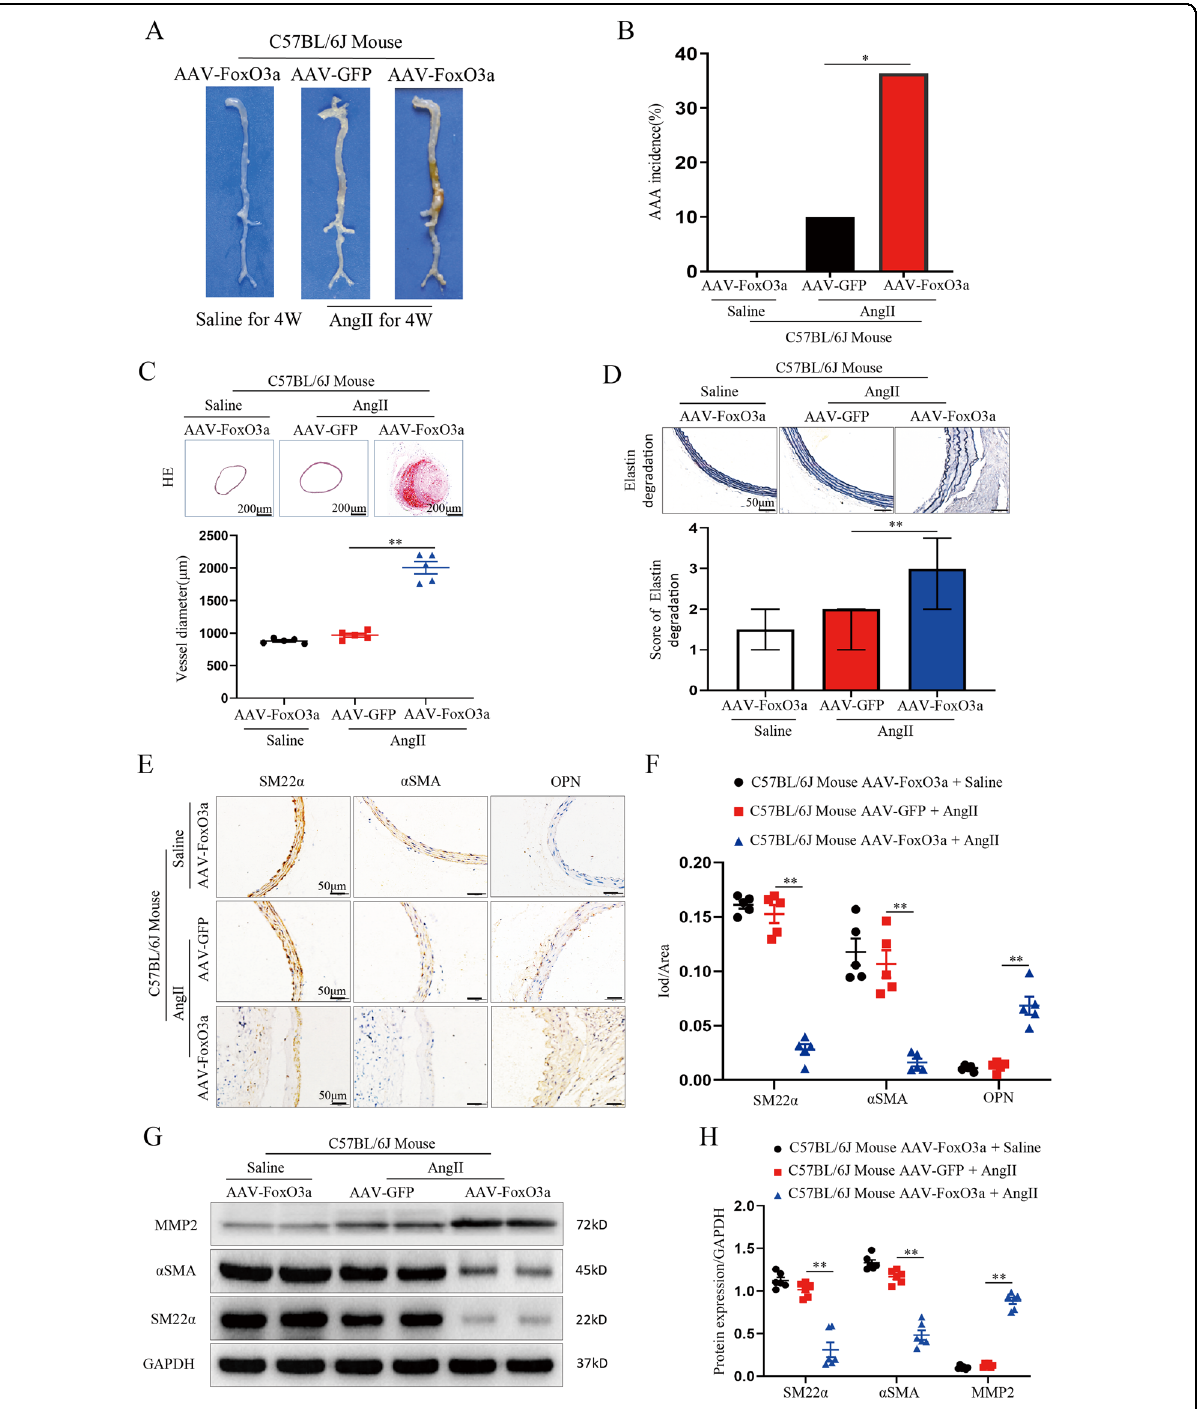
Fig. 4 FoxO3a overexpression promotes AAA formation in Ang II-infused C57BL/6J mice. Male C57BL/6J mice were treated with saline or AAV- FoxO3a or AAV-GFP, followed by infusion with saline or Ang II for 28 days. Data are presented as the mean ± SE; n = 10 in the AAV- FoxO3a group (mice treated with saline), n = 30 in the AAV-FoxO3a or AAV-GFP group (mice treated with Ang II). A Representative photographs showing AAAs in 3 groups of Ang II-treated C57BL/6J mice. B Statistical analysis of the AAA incidence. C Hematoxylin-eosin staining and maximal diameter of the abdominal region in C57BL/6J mice ( n = 5). D Representative staining with elastin in the abdominal aortas in 3 groups of C57BL/6J mice. Photographs show the location where the most severe elastin degradation occurred (scale bars = 50 µm; magni fi ed photographs, n = 15). E and F Representative staining of the SM22 α , α -SMA and OPN proteins (scale bars, 50 µm, n = 5). G and H WBs and densitometric analysis of aortic MMP2, α -SMA and SM22 α in C57BL/6J mice ( n = 6). Data are presented as the mean ± SE. * p < 0.05, ** p < 0.01.